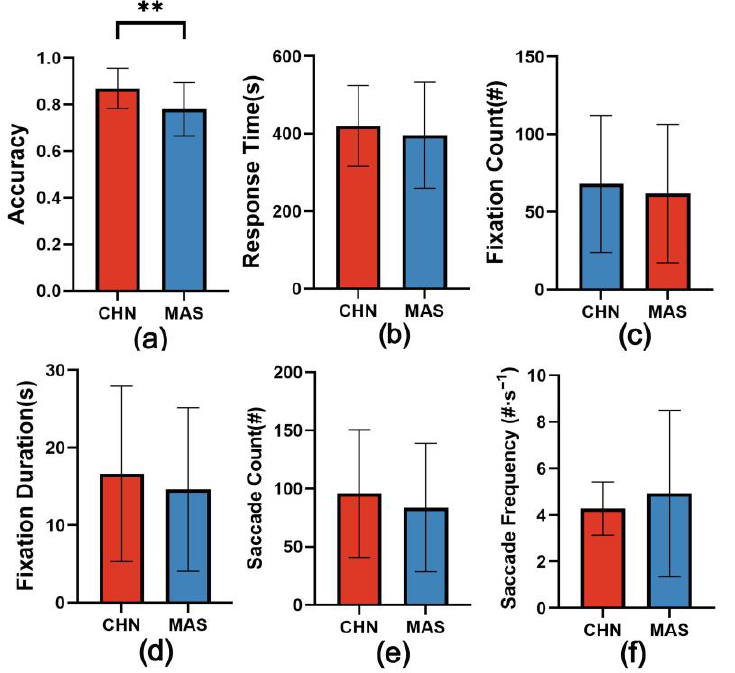
Figure 4. Statistics in the mental rotation task: ( a ) accuracy; ( b ) response time; ( c ) fixation count; ( d ) fixation duration; ( e ) saccade count; ( f ) saccade frequency (* p < 0.05, ** p < 0.01).